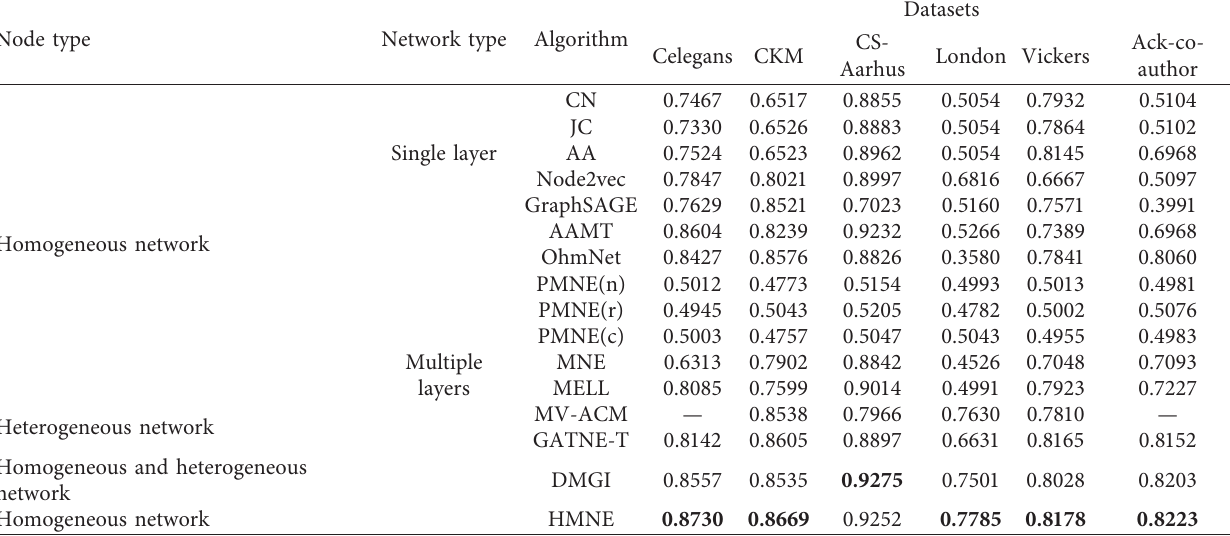
Table 3: Cross-domain link prediction task. All the results are the averaged AUC scores. Node